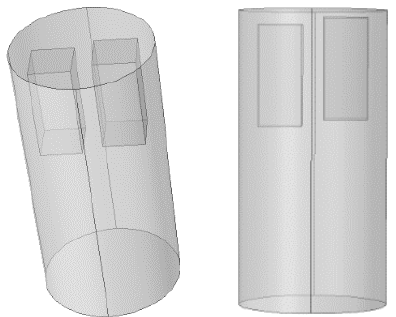
Figure 7: Defects location in the software